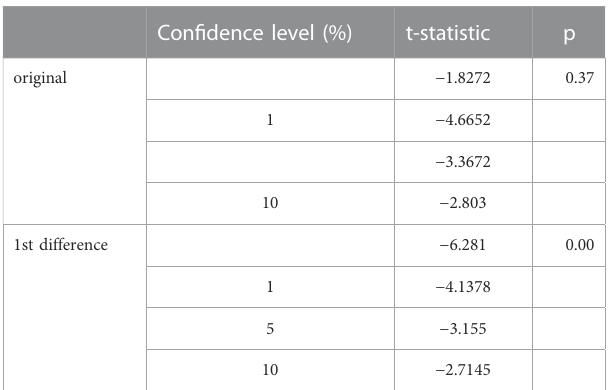
TABLE 9 Results of the ADF test in China. TABLE 10 Results of the ADF test in